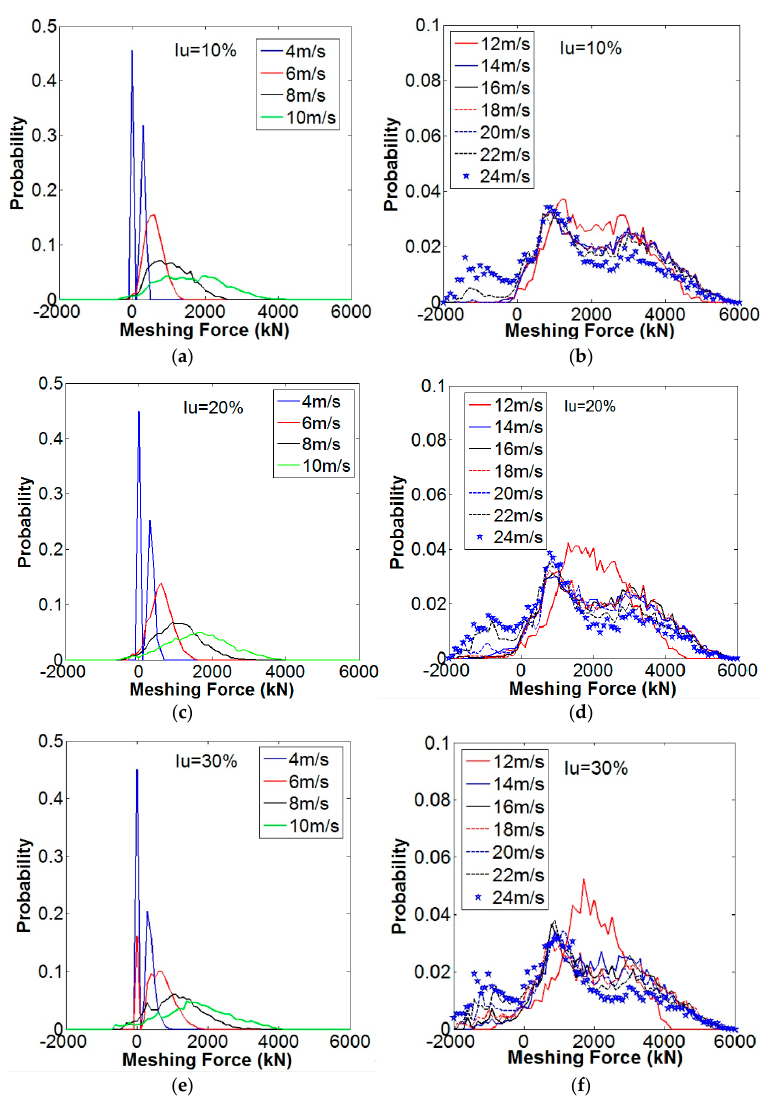
Figure 9. Distribution of meshing forces between planetary gear and sun gear for mean wind speeds varying from 4 to 24 m/s with different wind turbulence intensities. ( a , b ) 10%; ( c , d ) 20%; ( e , f )